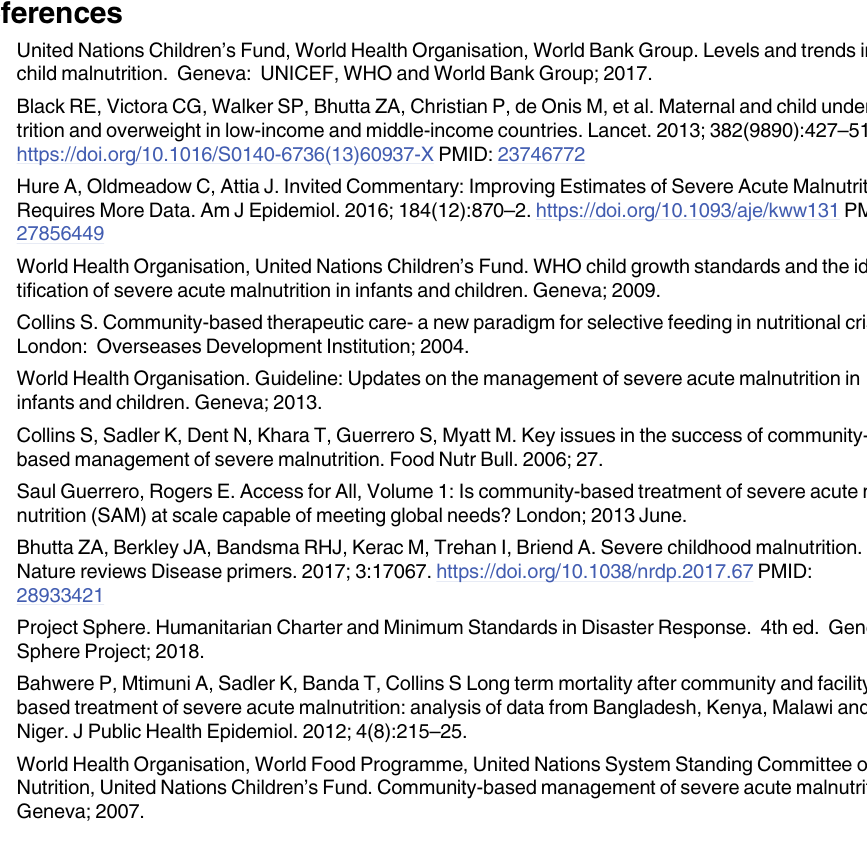
S2 Table. Quality assessment of